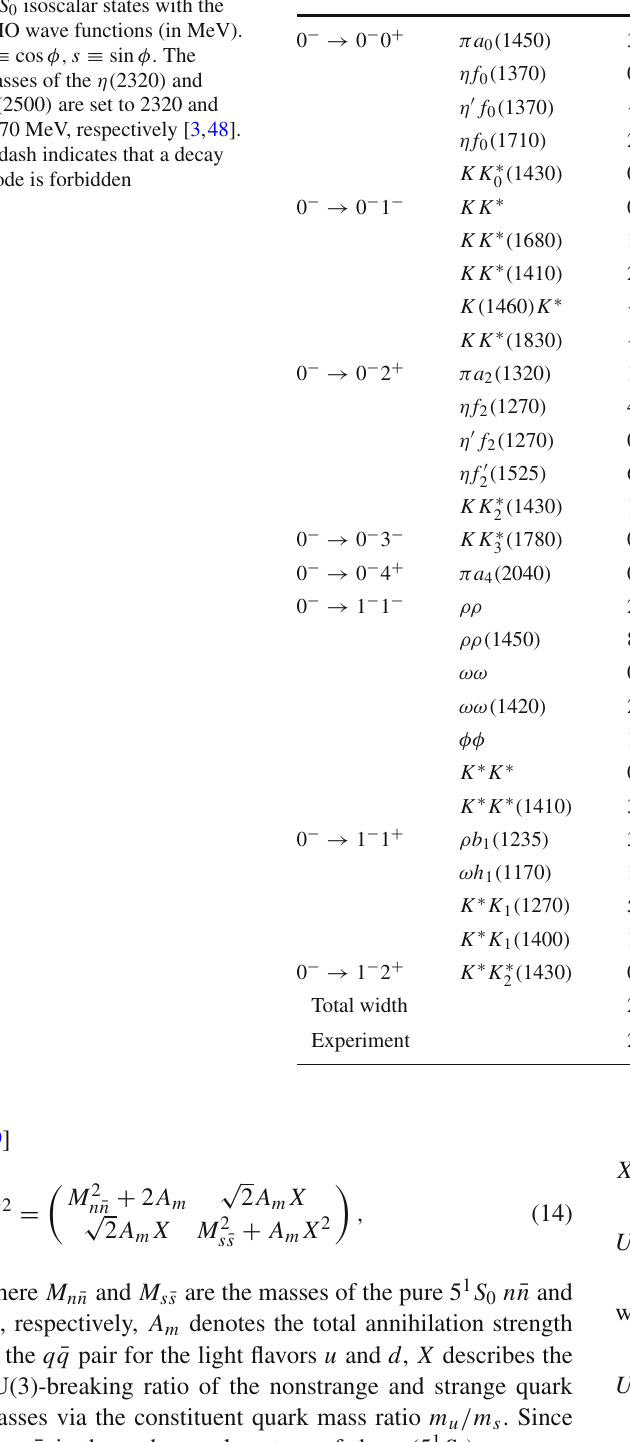
Table 3 Decay widths of the η( 2320 ) and X ( 2500 ) as the 5 1 S 0 isoscalar states with the SHO wave functions (in MeV). c ≡ cos φ, s ≡ sin φ. The masses of the η( 2320 )